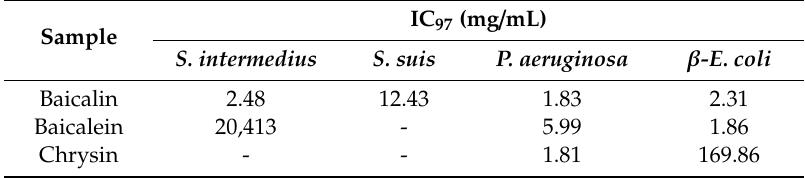
Table 2. Ninety-seven percent inhibitory concentrations (IC 97 ) of flavones in O. indicum . IC 97 (mg / mL) Sample S.